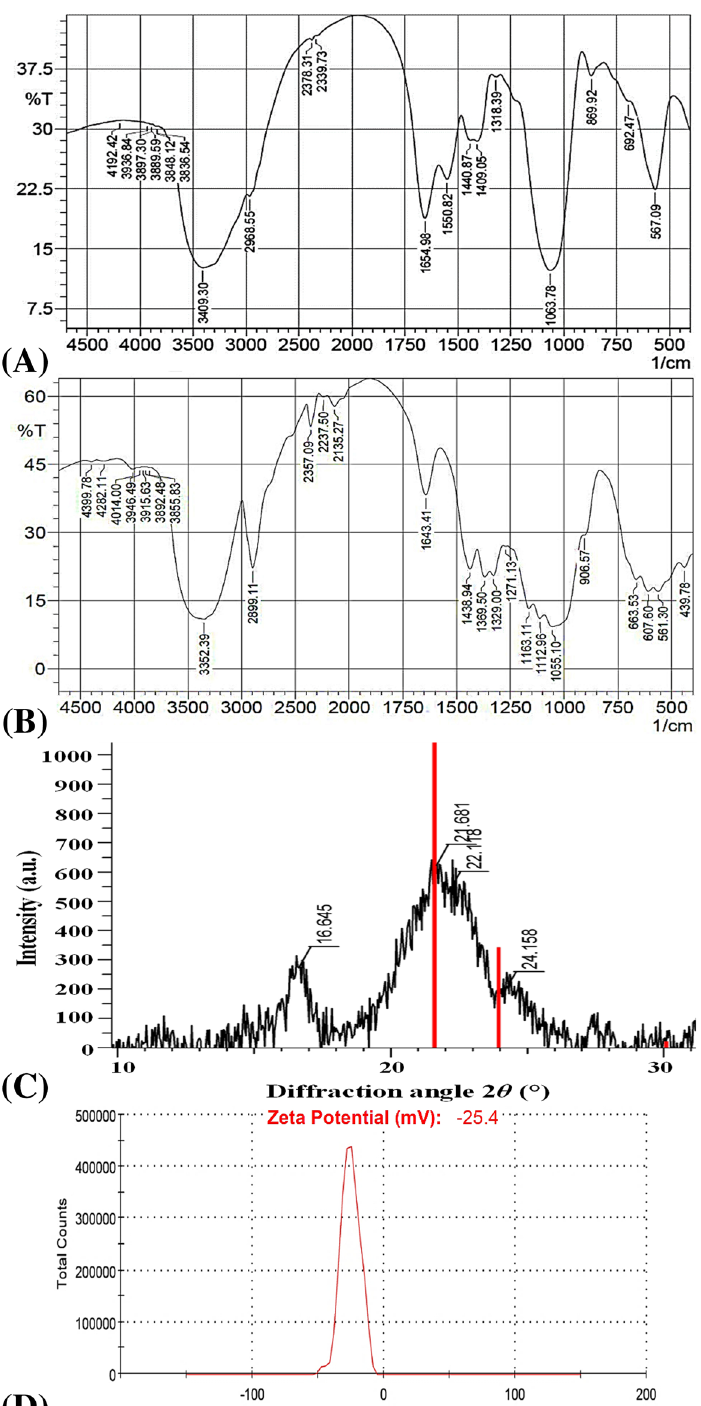
Figure 8. FTIR spectra of BNC sample ( A ) andAvicel PH101( B ). X-ray diffraction ( C ) and Zeta potential ( D